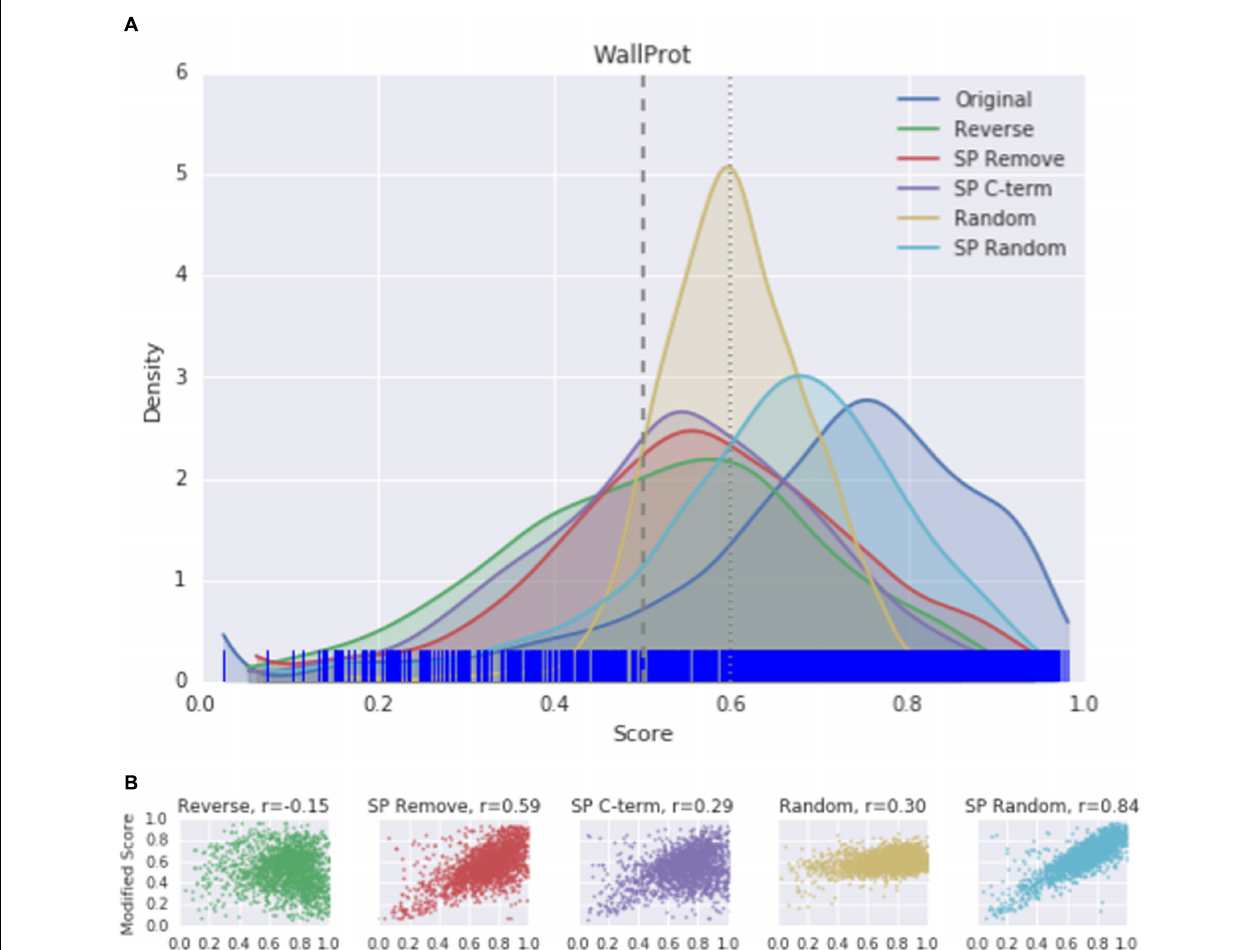
FIGURE 3 | (A) The kernel density estimation (KDE) distributions of SecretomeP scores (v1.0) for original and modified sequences of the entire WallProtDB dataset. (Individual KDE distribution plots for sub-sets of WallProtDB are provided in Supplementary Figure S1). Rug plot marks along the x -axis indicate position of original scores. Vertical dashed lines at 0.5 and 0.6 represent the most common cutoff scores used in plant studies. (B) Correlation plots between original scores ( x -axis) and modified scores ( y -axis). Spearman correlation values are indicated for each